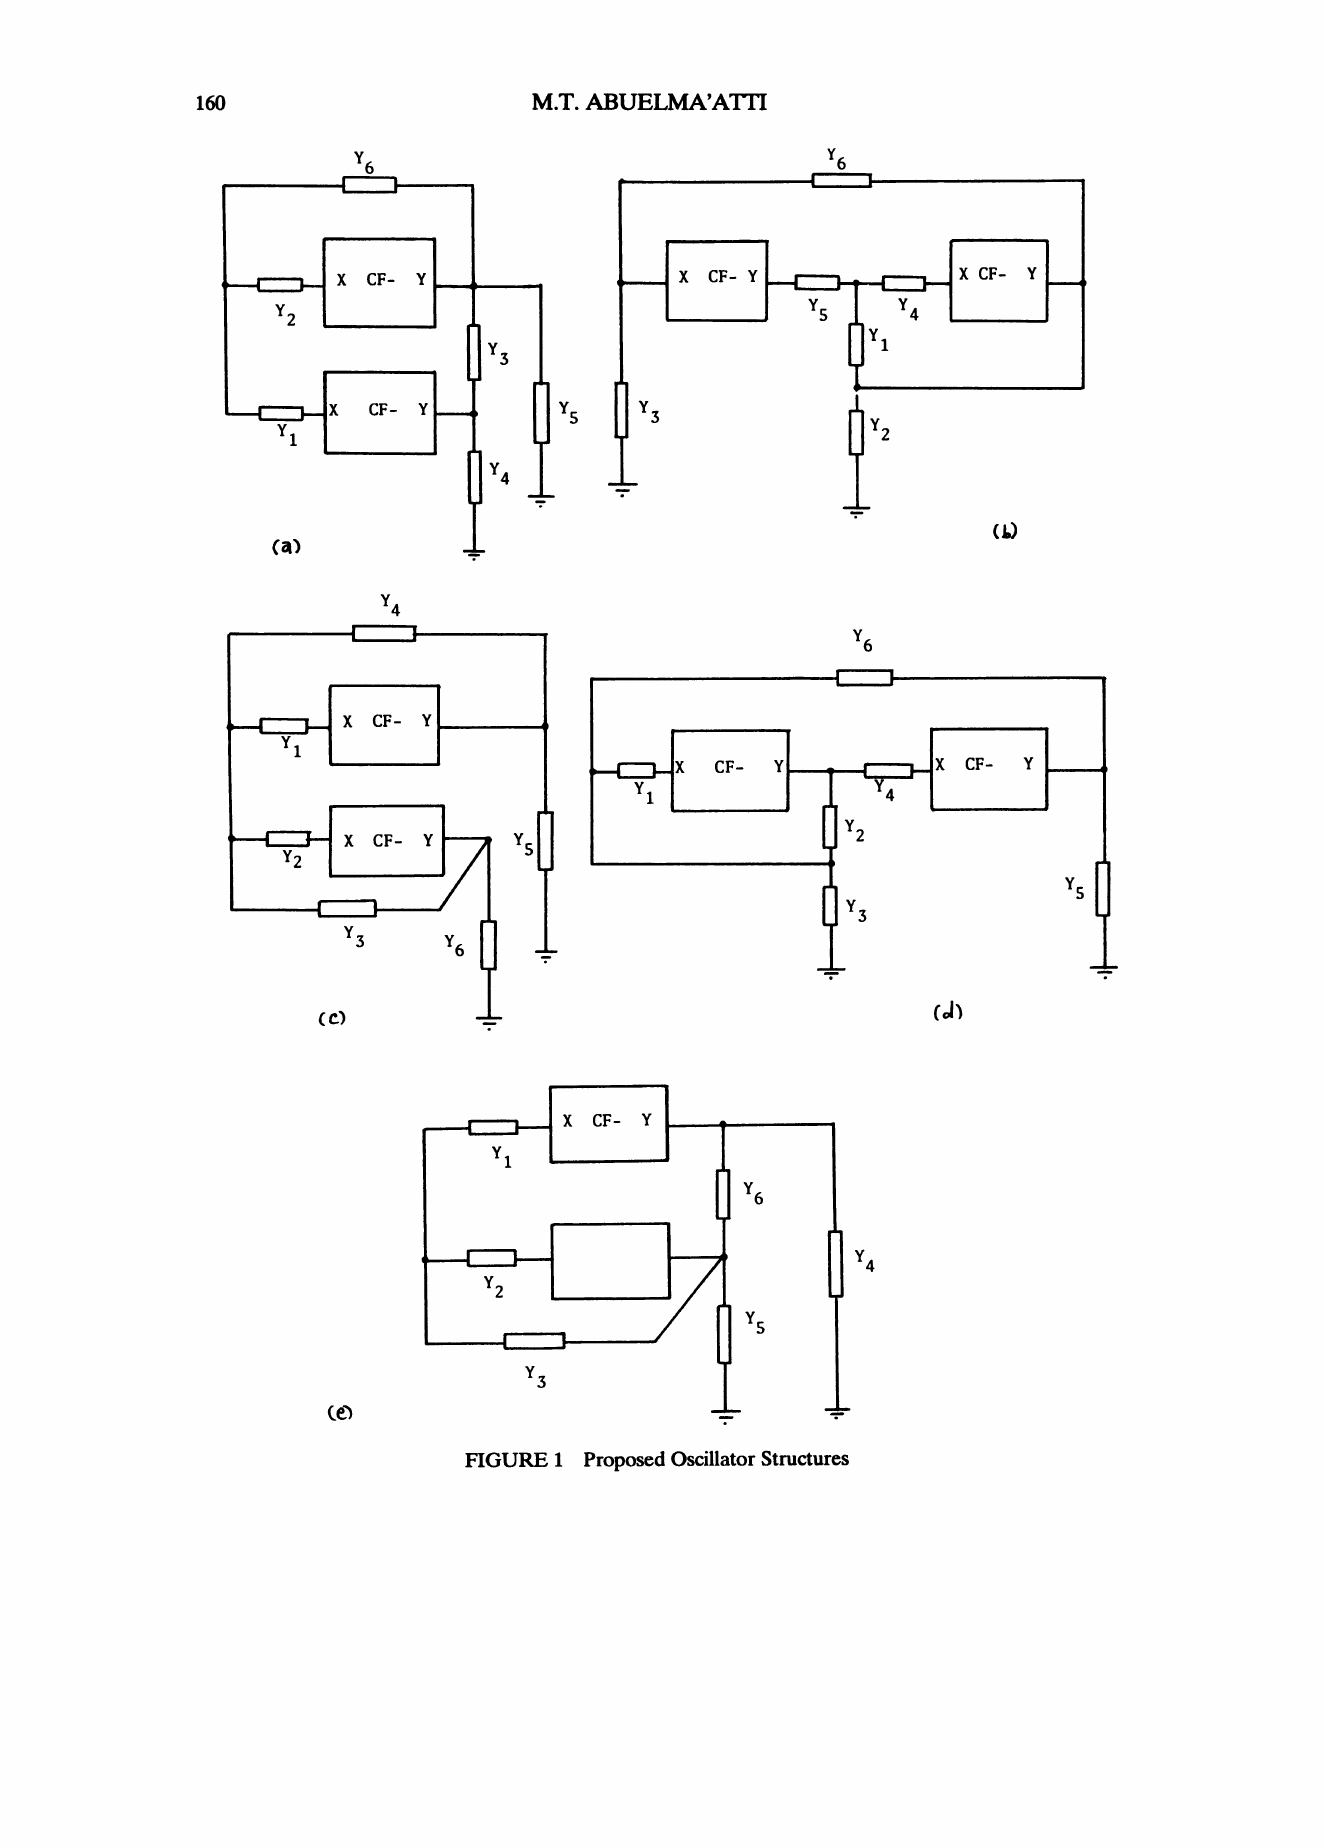
FIGURE 1 Proposed Oscillator